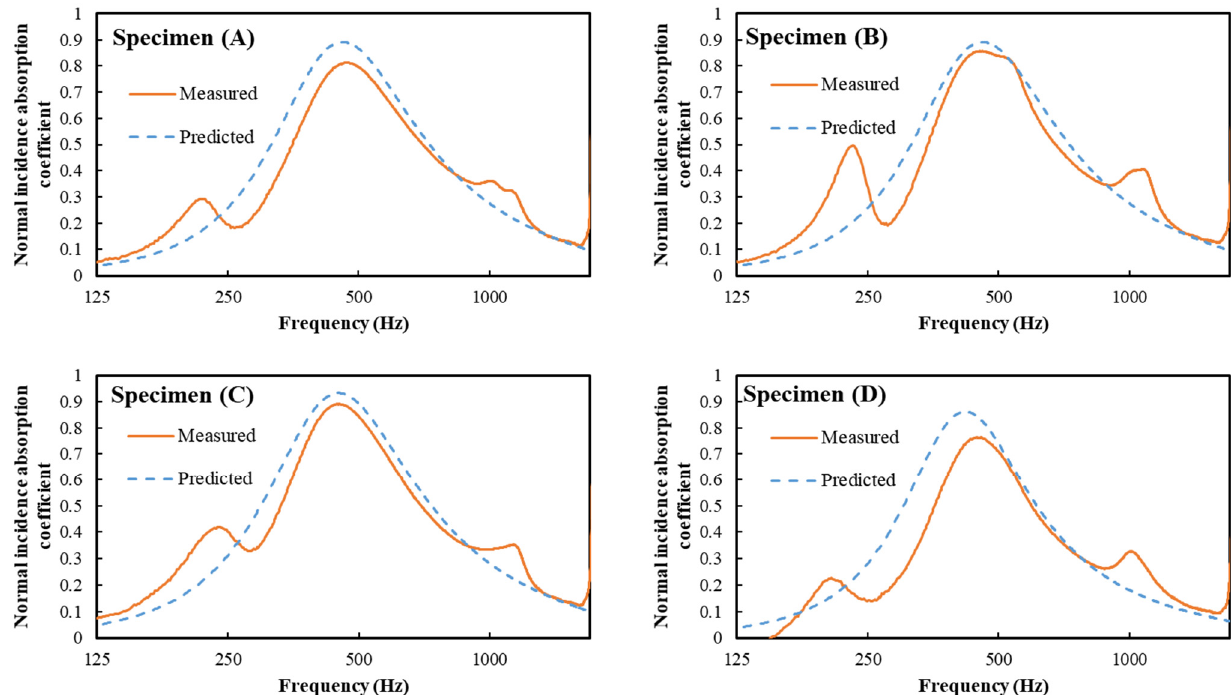
Figure 11. Measured results for the normal incidence absorption coefficient and their comparison with predicted values when the air cavity is 75 mm. Solid line: Measured; dashed line: Predicted. The parameters of Specimens (A), (B), (C) and (D) are detailed in Table 1 and Figures 1–4.